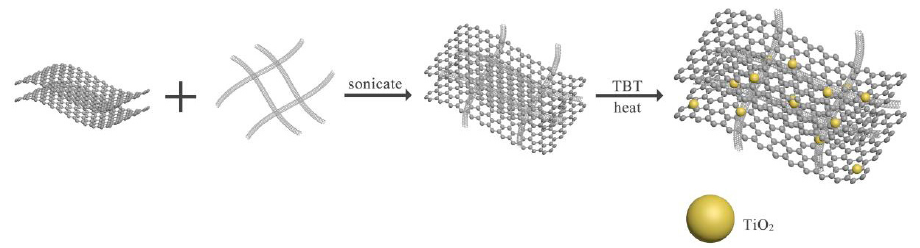
Figure 1. The schematic illustration of TiO 2 /carbon nanotubes (CNTs)/ reduced graphene oxide (rGO) composites.